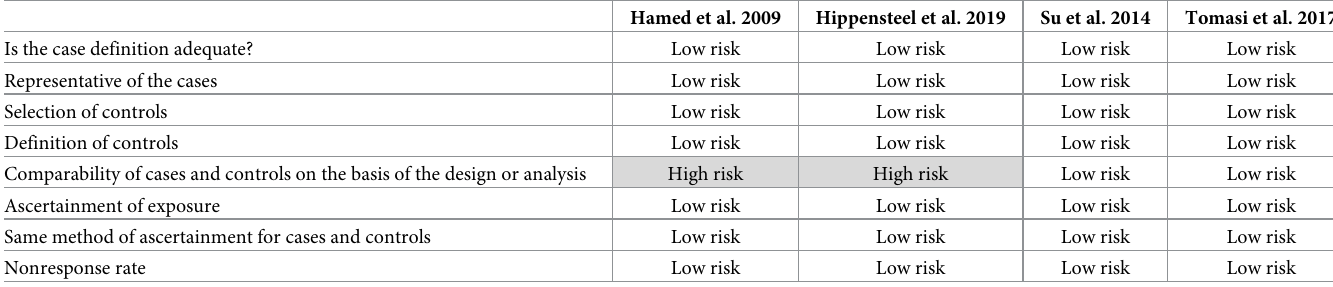
Table 2. Risk of bias